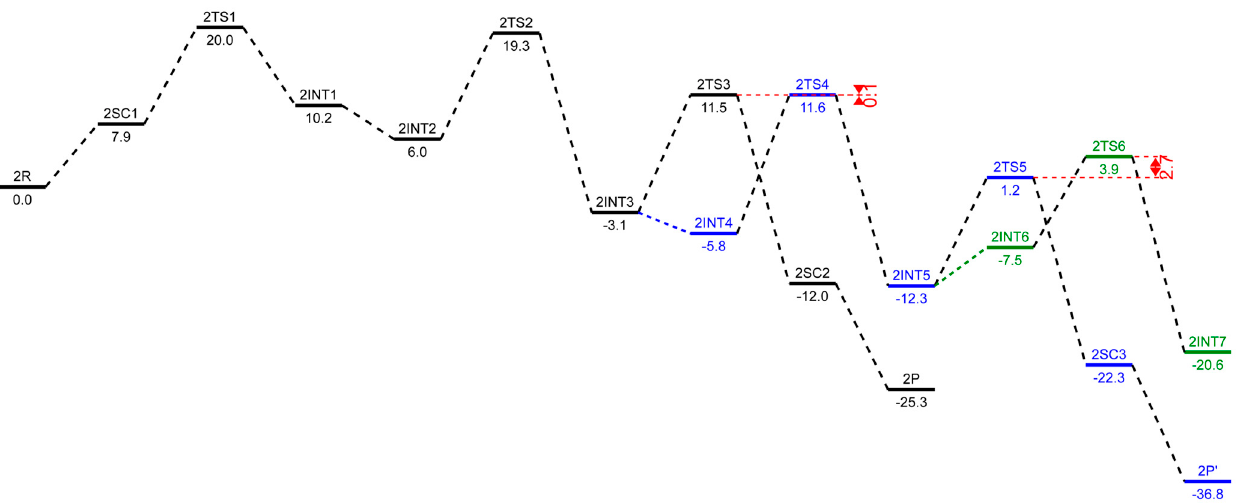
Figure 6. Corrected free energy profiles (in kcal/mol) at the level of B3LYP/6-311++G(d,p) with GD3BJ for ethylene trimerization in black, tetramerization in blue, and petamerization in green using the para -methoxyaryl Cr-PNP catalyst. The SMD polarizable continuum solvent model was used for solvent effect correction.